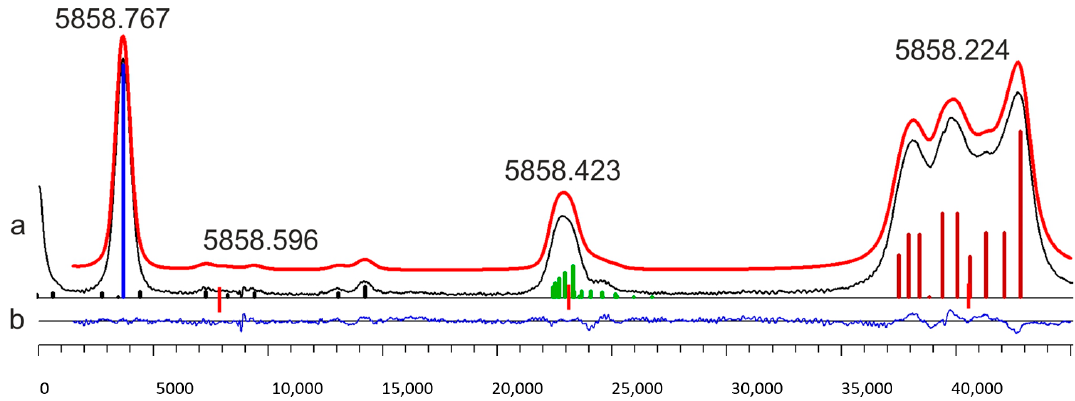
Figure 1. Optogalvanic laser scan starting at 5858.68 Å. ( a ) Experimental record (black), fitted curve (red), and hf components. The red bars mark the cg frequencies. ( b ) Difference between experimental and fitted trace, magnified by a factor of 1.84. The line at 5858.224 Å enabled the discovery of the new level at 41,975.663 cm − 1 (see Table 1).